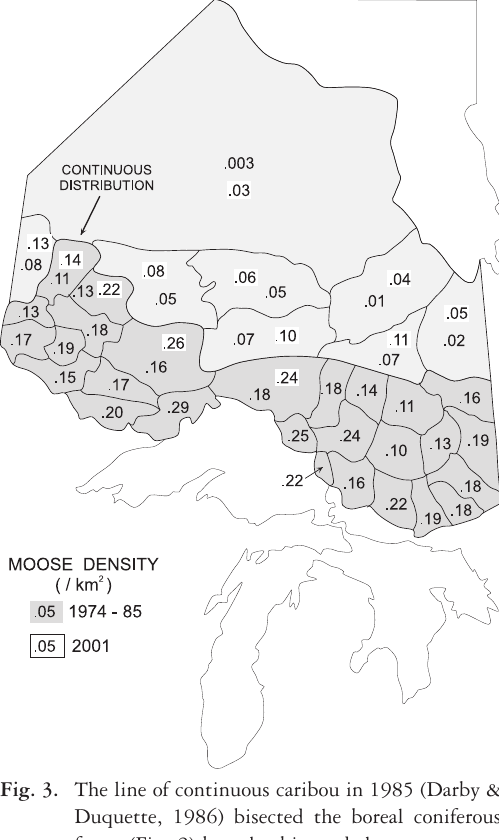
Fig. 3. The line of continuous caribou in 1985 (Darby & Duquette, 1986) bisected the boreal coniferous forest (Fig. 2) but also bisected the moose range with moose densities greater than 0.10/km 2 south of the discontinues distribution of caribou and the continuous distribution north of the line. Only relic herds are still found south of the line that have special escape habitat such as PNP with the Lake Superior coast and the herds on islands in Lake Superior, i.e. Slate Islands, Pic Island and Michipicoten Island (Bergerud, 1989). The moose have increased north of the line between 1985 and 2001 and wolves are predicted to exceed 6.5/ km 2 causing herds to decline in WMUs that now have more than 0.10 moose/km 2 . Densities are based on OMNR statistics from the Thunder Bay office provided to me in 1989 and in